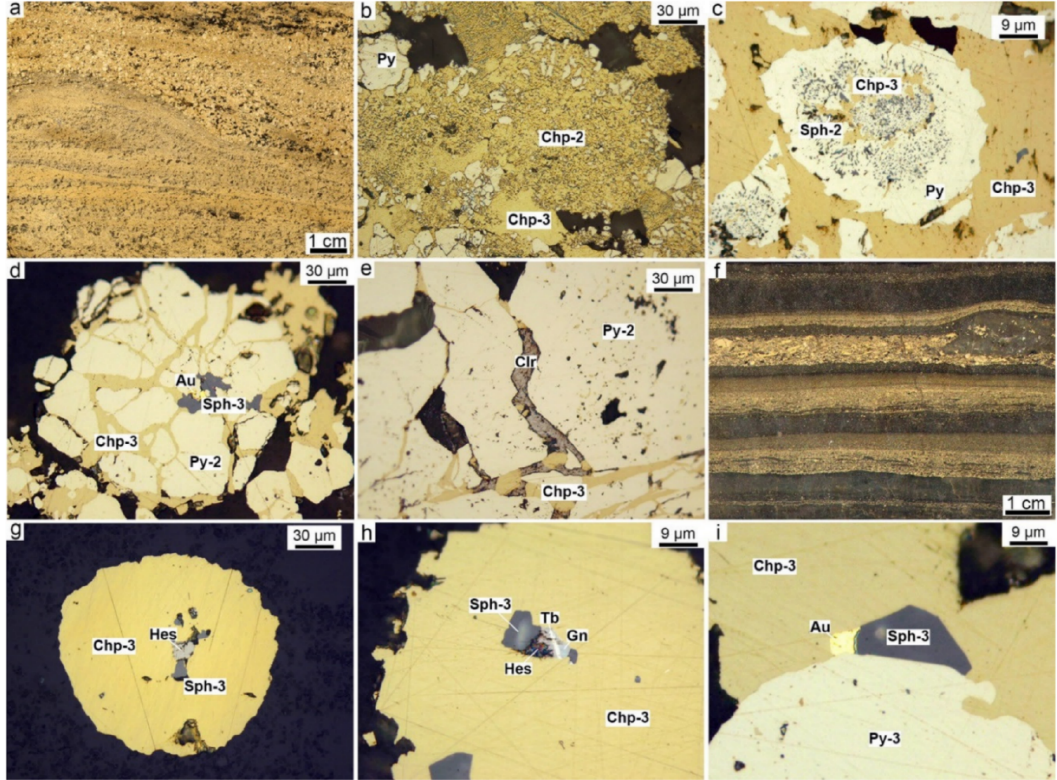
Figure 7. Mineralogical features of chalcopyrite-rich diagenite of the Yubileynoe deposit: ( a ) Chalcopyrite-rich layers with disseminated pyrite; ( b ) fine- and coarse-grained chalcopyrite-2 and -3 with relict pyrite clasts after etching in HNO 3 ; ( c ) pyrite nodule with a core partly replaced by sphalerite-2 and chalcopyrite-3; ( d ) chalcopyrite-3 and sphalerite-3 with native gold partly replacing coarse-grained pyrite; ( e ) coloradoite and chalcopyrite-3 veinlets in pyrite; ( f ) sulfide turbidites intercalated with hyaloclastic shales; ( g ) inclusions of sphalerite-3, hessite and galena in the core of chalcopyrite-3 nodule; ( h ) inclusions of sphalerite-3, galena, hessite and tellurobismuthite in the chalcopyrite-3 nodule; ( i) intergrowth of native gold and pyrite-3 and sphalerite-3 in chalcopyrite-3 nodule. ( a , f ) Polished sample, ( b – e , g – k ) reflected